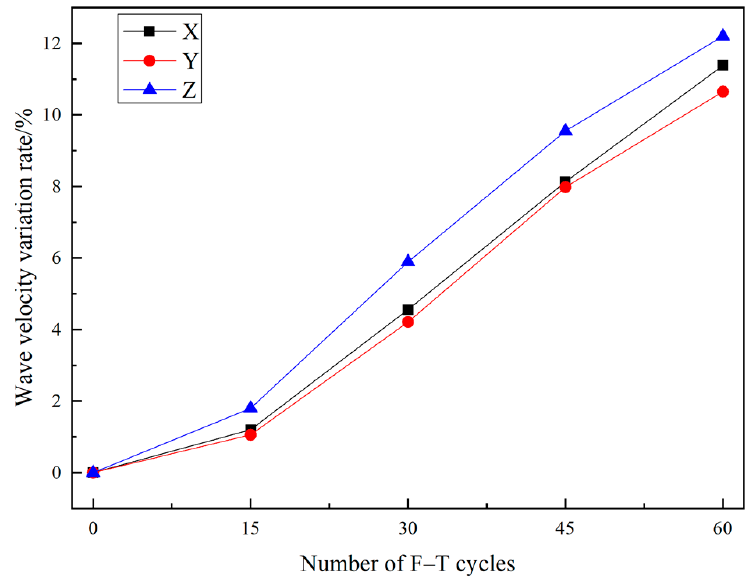
Figure 5. Wave velocity curve of three freeze–thaw cycle treatments.